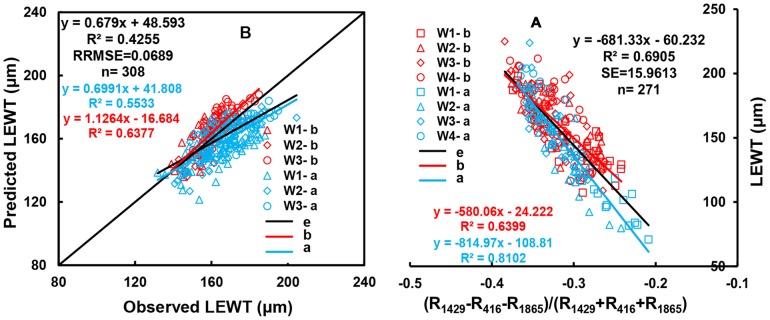
Quantitative relationships between (R1429−R416−R1865)/(R1429+R416+R1865) between LEWT in wheat (A); the 1∶1 relationship between the predicted and observed LEWT on (R1429−R416−R1865)/(R1429+R416+R1865) (B).